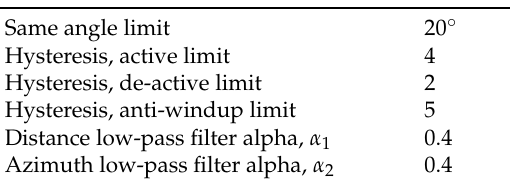
Table 3. Exploration vectors filter.